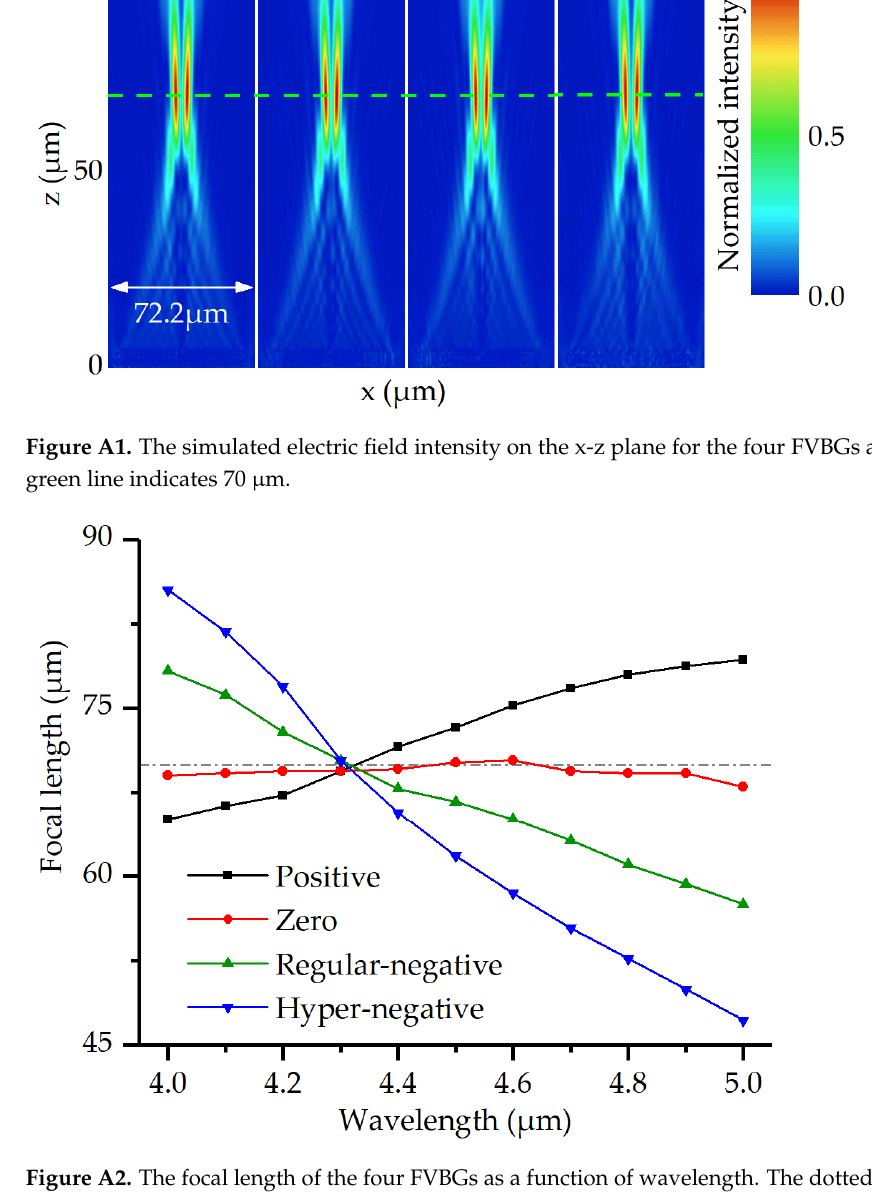
Figure A2. The focal length of the four FVBGs as a function of wavelength. The dotted line indicates 70 μ m.